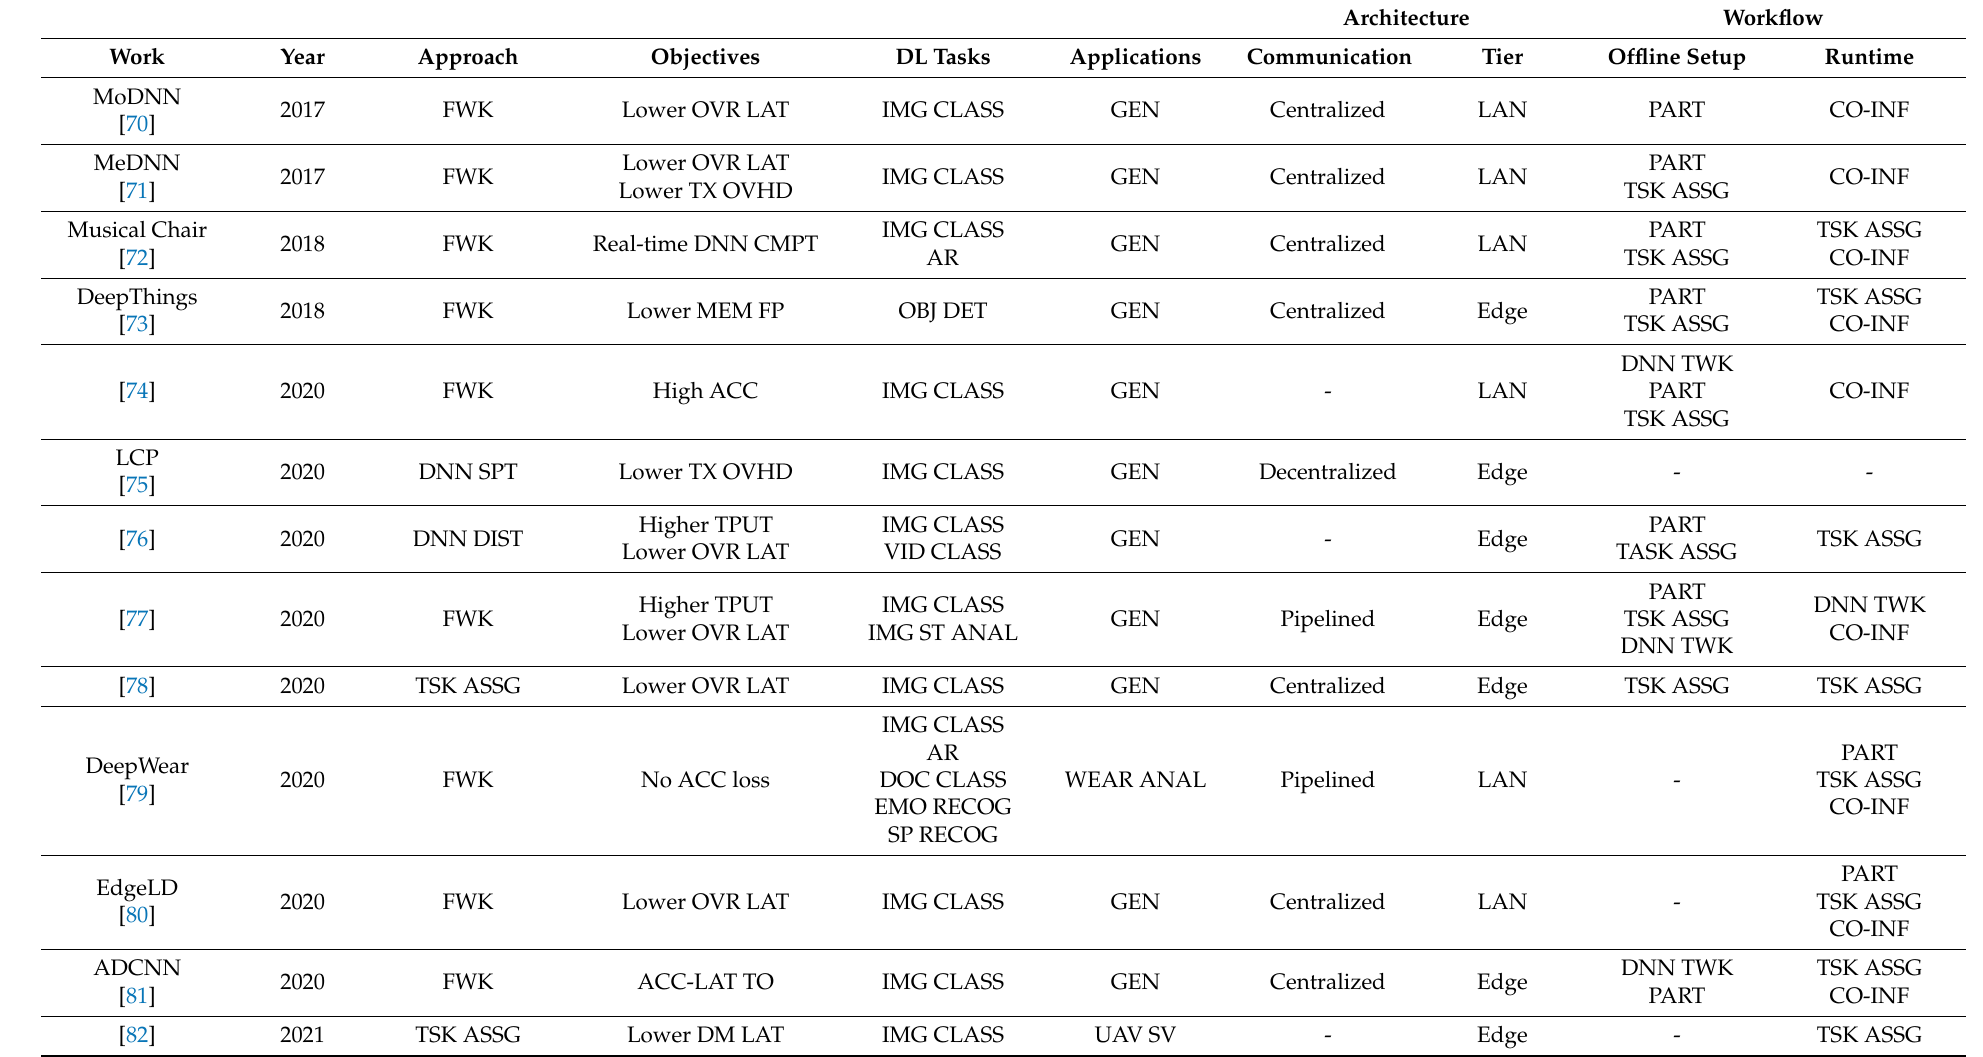
Table 2. Recent research efforts that study the distribution of DL workloads within an IoT cluster.